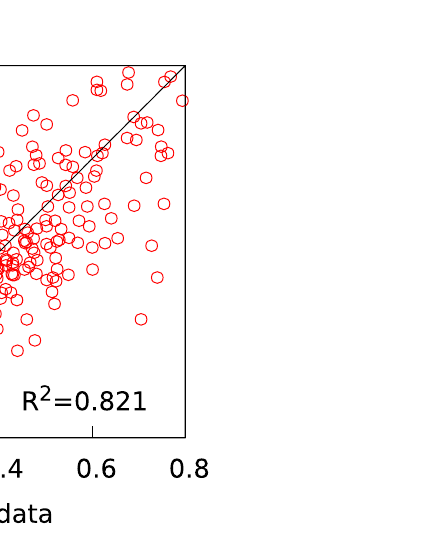
Figure 3. Regression curves of stress corresponding to various strain values on the LCE stress–strain